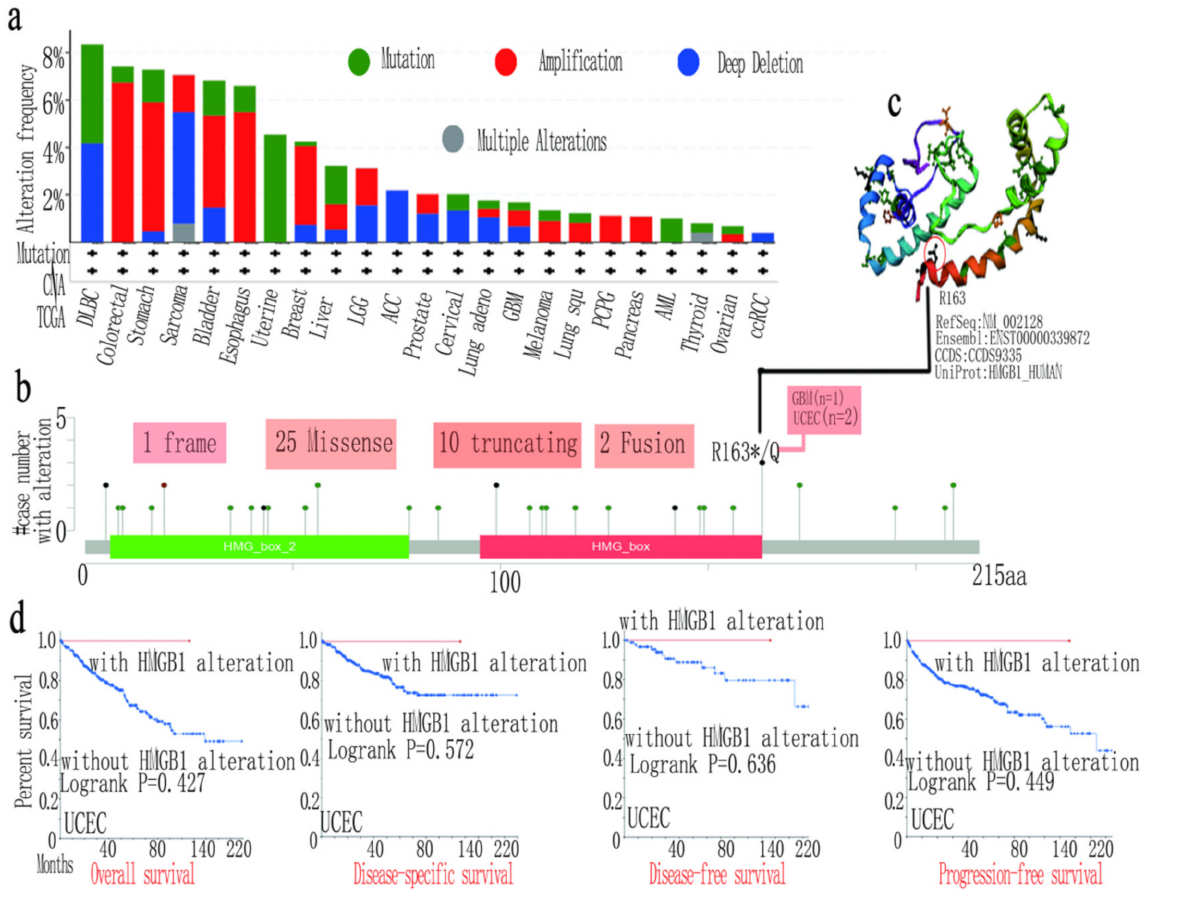
Figure 4. HMGB1-related mutation feature in various cancers in TCGA database. ( a ) HMGB1-related mutation type. ( b ) Multiple genetic mutation sites. ( c ) Highest alteration frequency (R163*/Q) in 3D structure of HMGB1. ( d ) Different survival statuses of UCEC with HMGB1